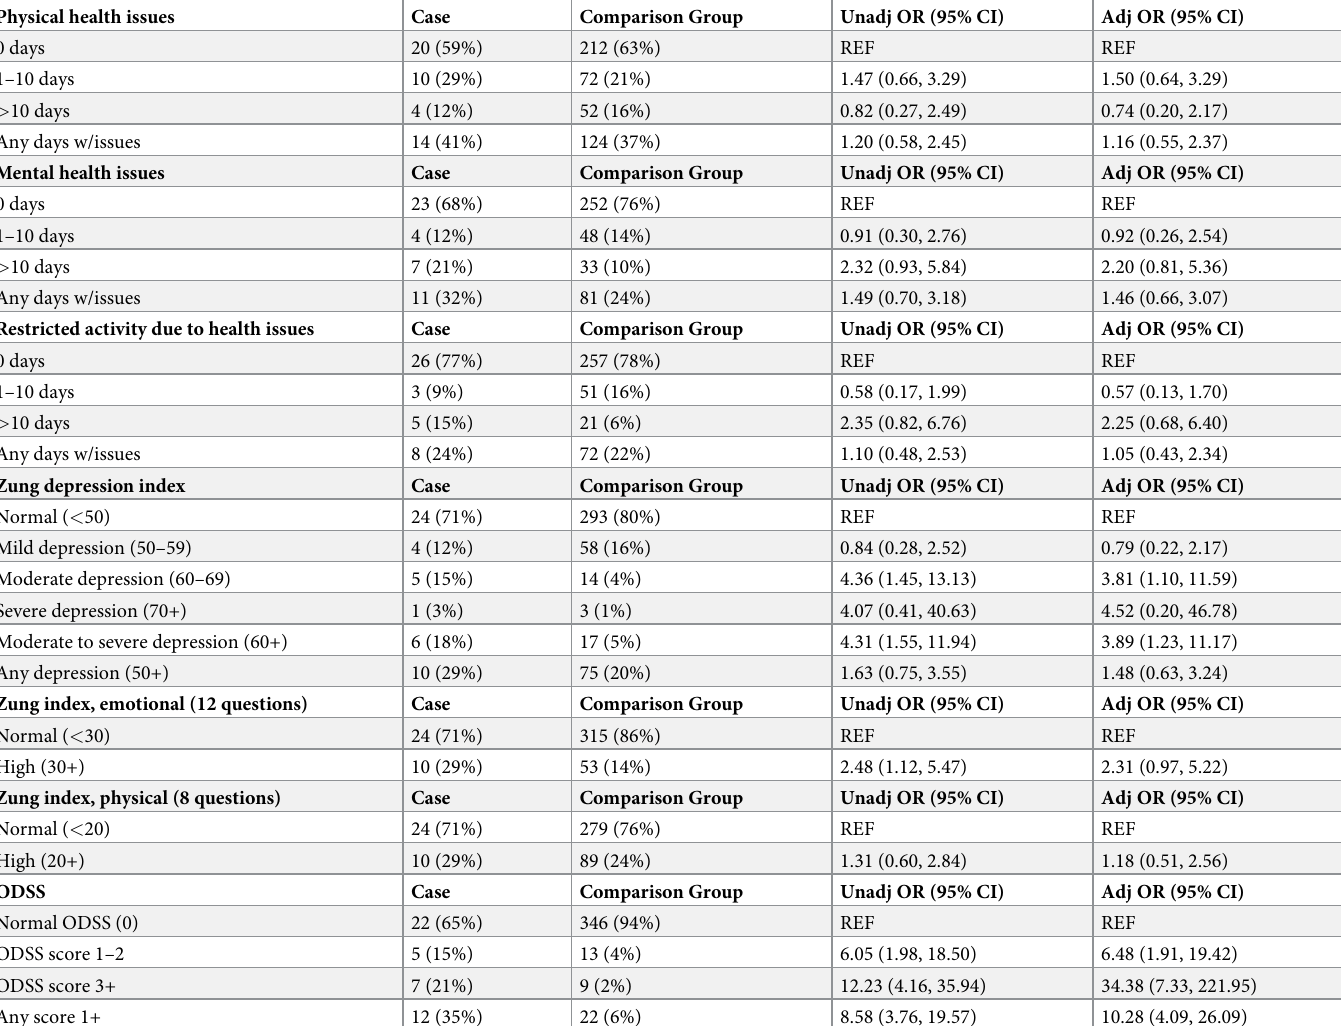
Table 5. Odds ratios comparing disability for GBS cases at follow-up with the comparison